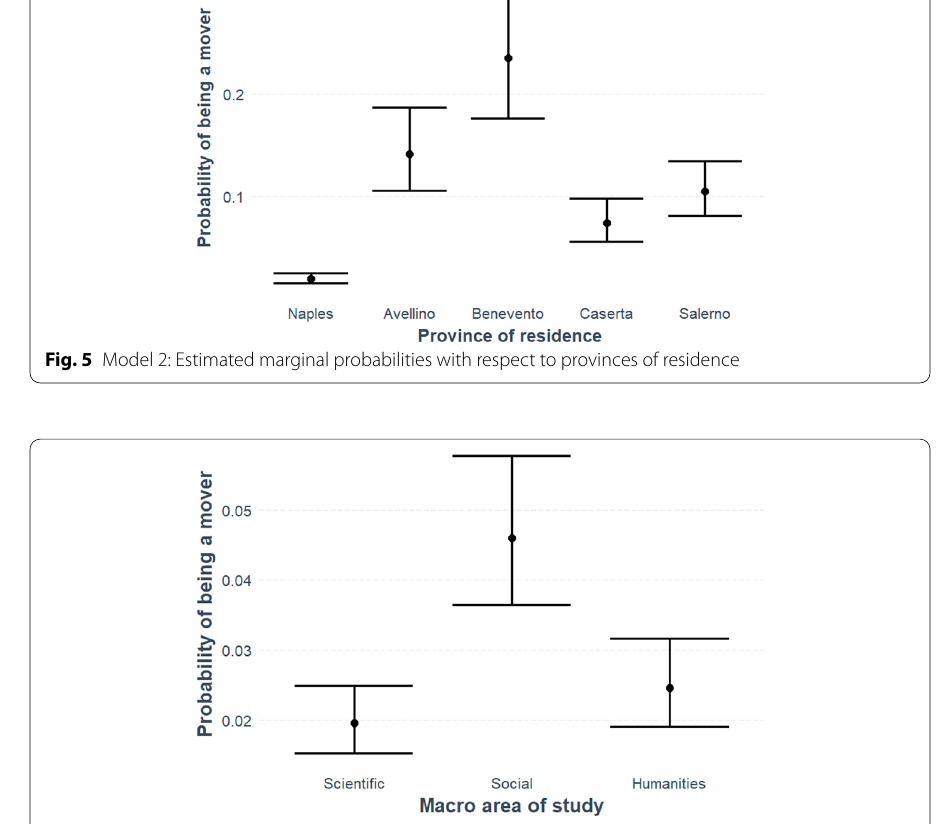
Fig. 6 Model 2: Estimated marginal probabilities with respect to the macro-area of